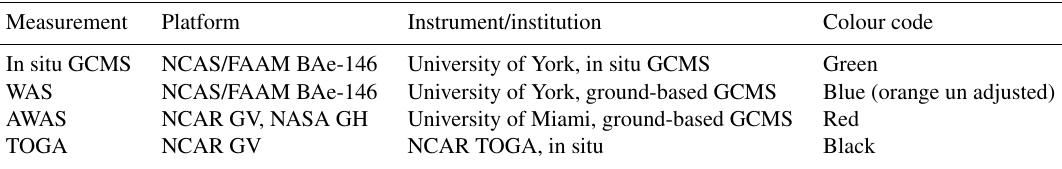
Table 1. Summary of measurement platforms, instruments and institutions. Colour code refers to the colour of data displayed in figures. Measurement Platform Instrument/institution Colour code In situ GCMS WAS